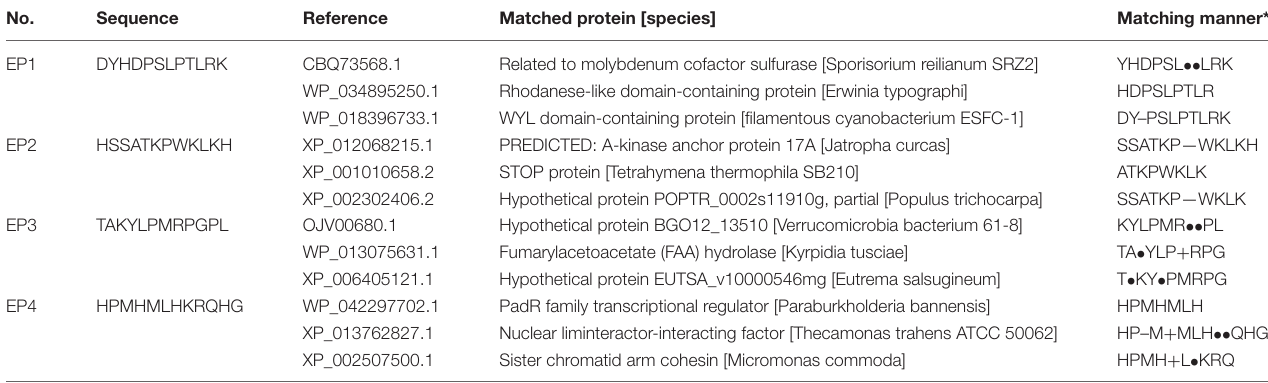
TABLE 5 | Matched proteins with the identified epitope